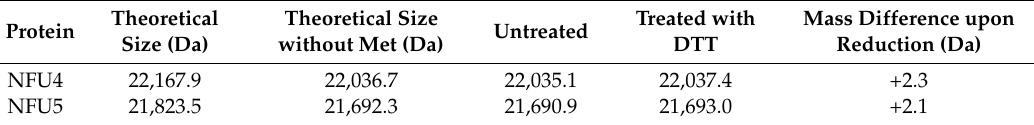
The mass accuracy is generally ± 0.5